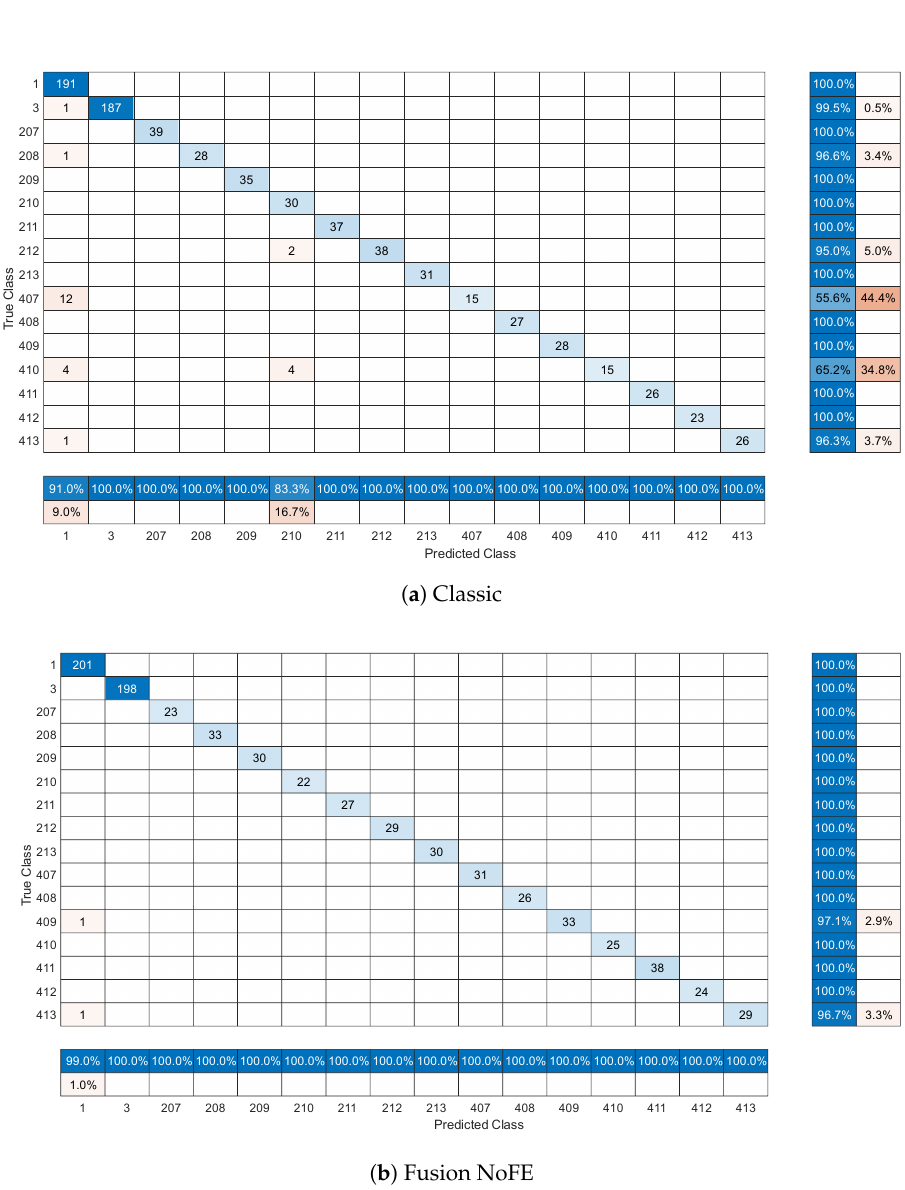
Figure 6. Confusion